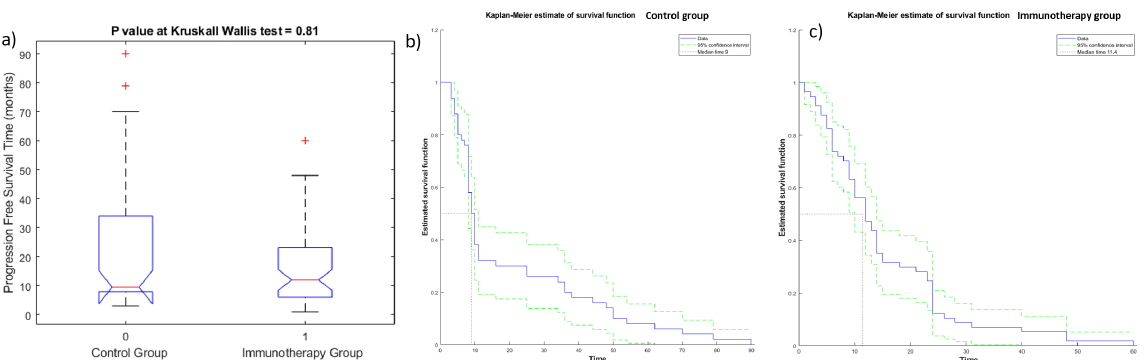
Figure 4. Boxplot ( a ) and Kaplan—Meier curve of PFS for patients of control group ( b ) and of immunotherapy group ( c ).